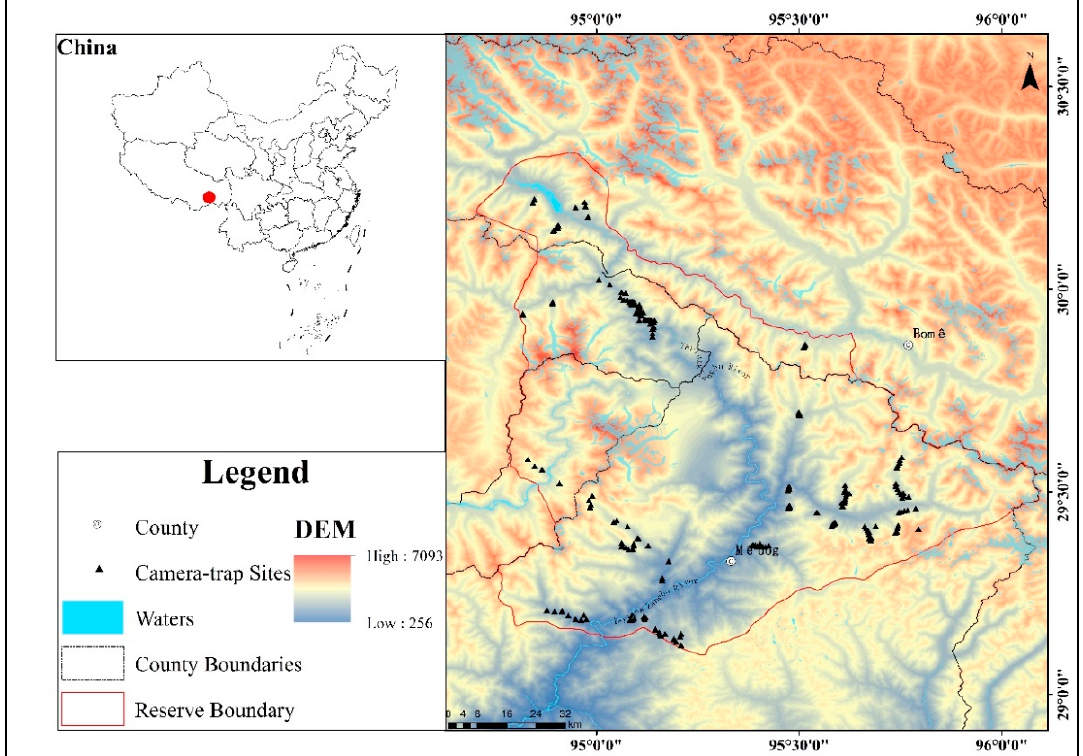
Figure 1. Study area and camera-trap sites.